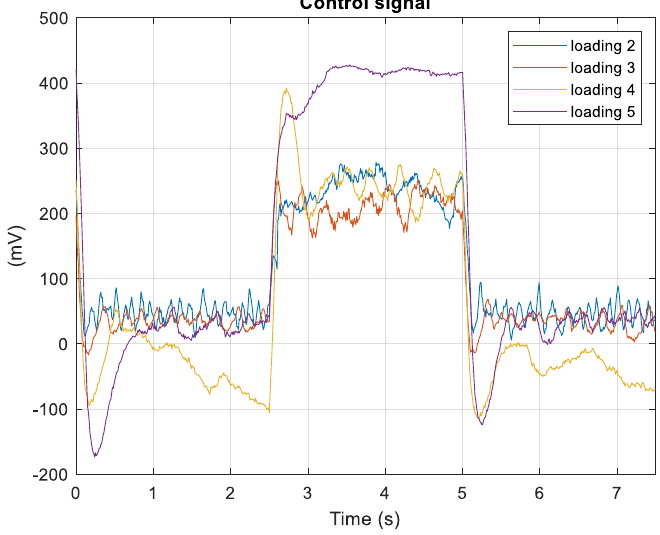
Figure 20. Comparison of control signals for different loading conditions.